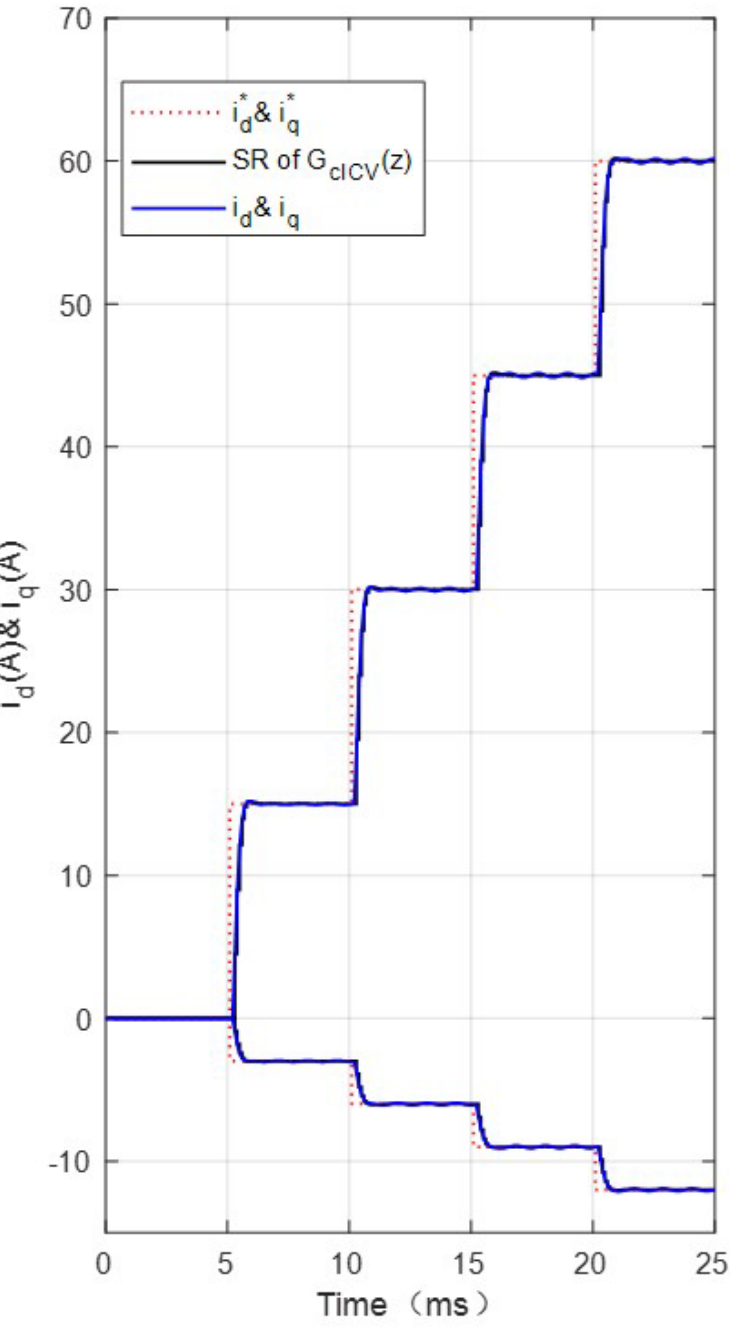
Figure 13. Simulation result of complex vector controller based on flux-linkage data ( k = 0.3, f s = 10 kHz) of the high-speed saturated machine ( f out = 833